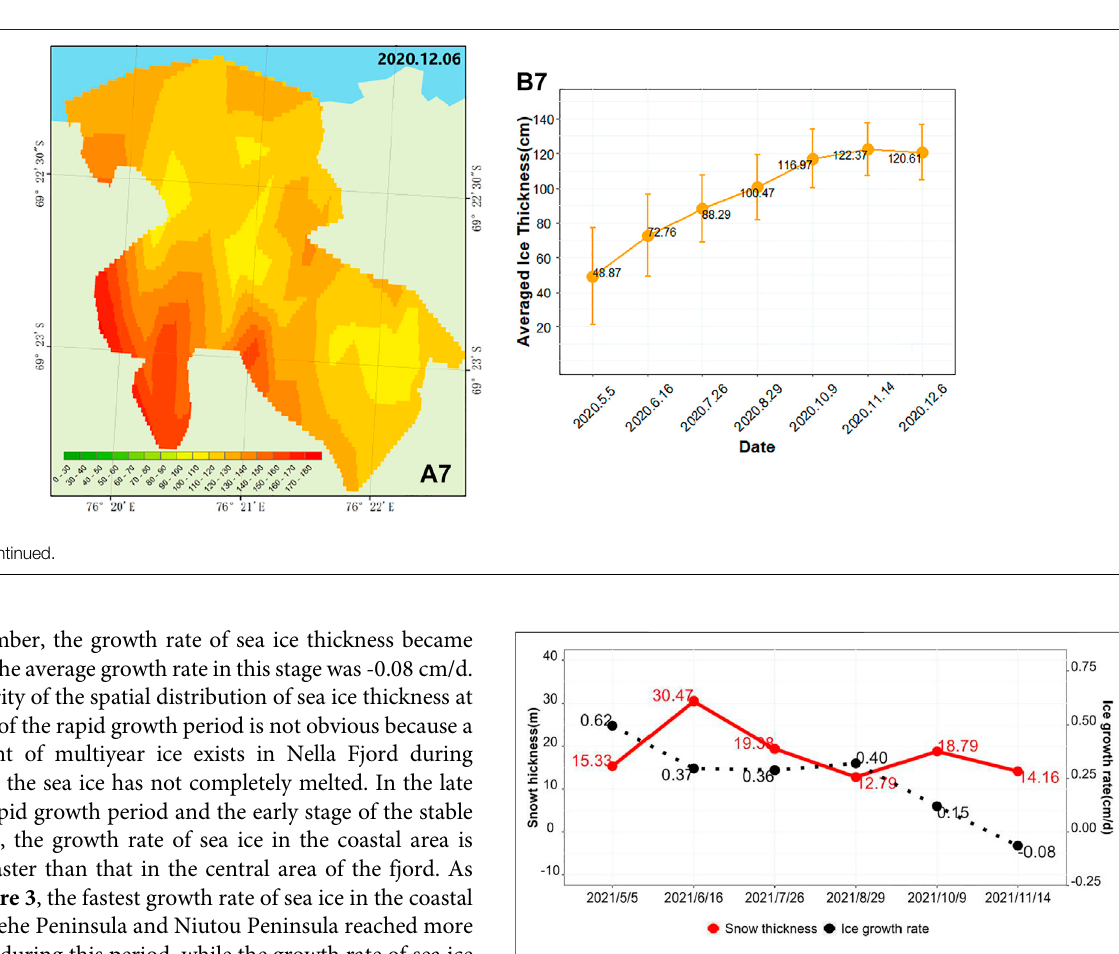
sea ice thickness increased. From August to October, the snow again. After early October, the average daily temperature